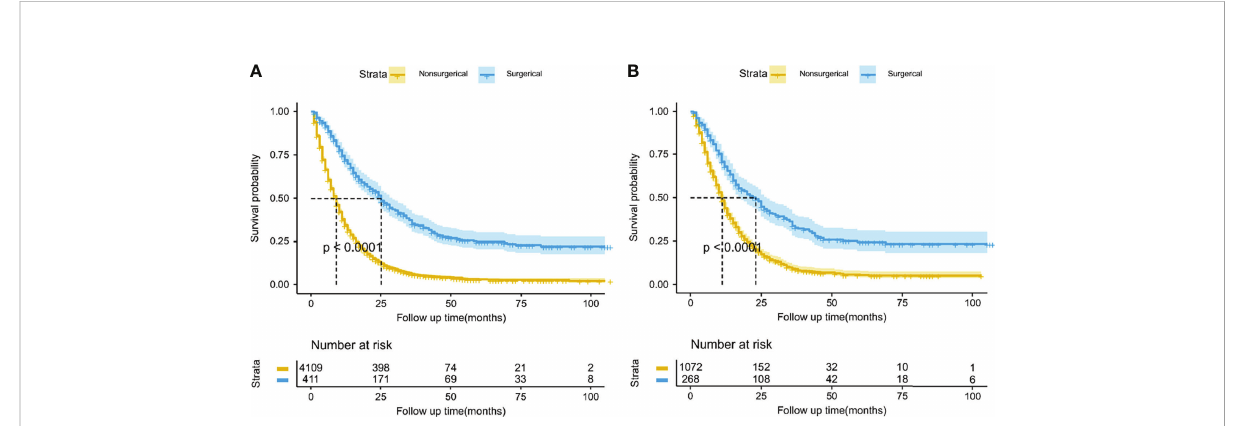
FIGURE 3 Kaplan-Meier overall survival curves between the surgical and nonsurgical treatment modalities before (A) and after (B) propensity score matching. The lightly colored width of the survival curve indicates the 95% con fi dence intervals of the Kaplan-Meier